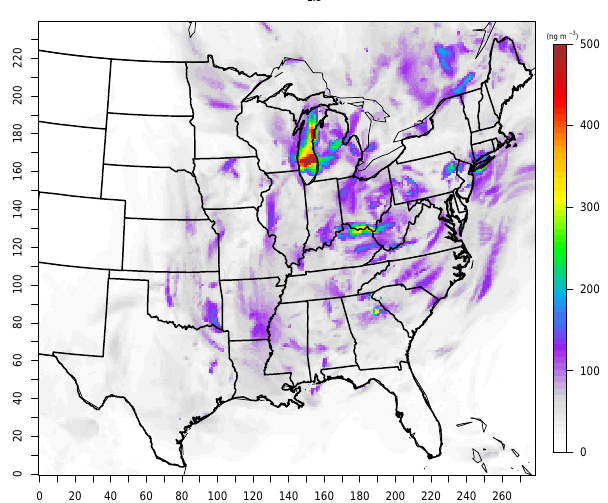
Figure 10. Maximum increase in hourly IEPOX/MPAN SOA ([AQCHEM − KMTI] − [AQCHEM − KMT]) (ngm − 3 ) for June 2013. Table 3. Observation–prediction statistics for 2-methyltetrols and 2-MG at the RTP measurement site during SOAS. 2-MG